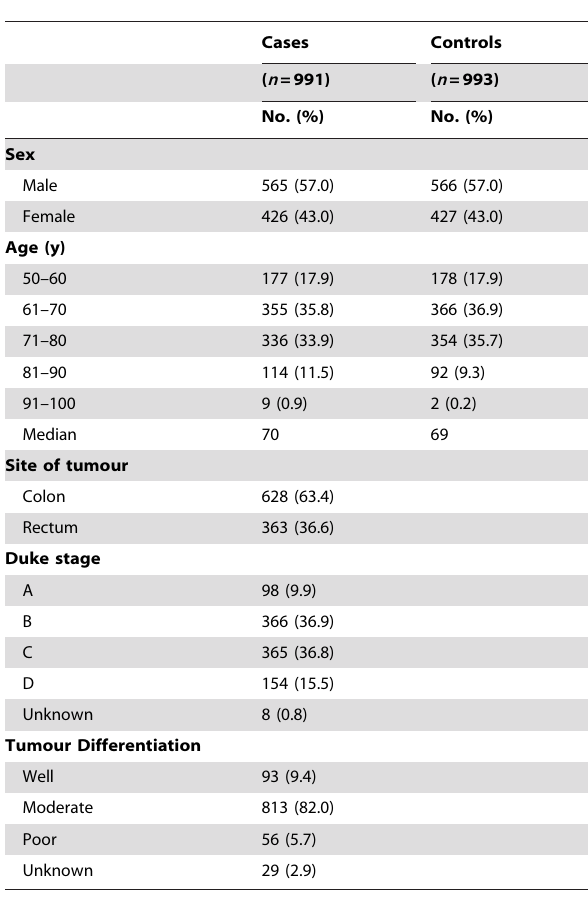
Table 1. Distribution of clinicopathological features among cases and